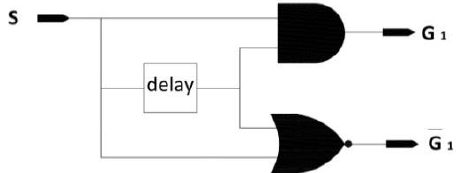
Figure 6. Logic circuit for the dead-time generation.